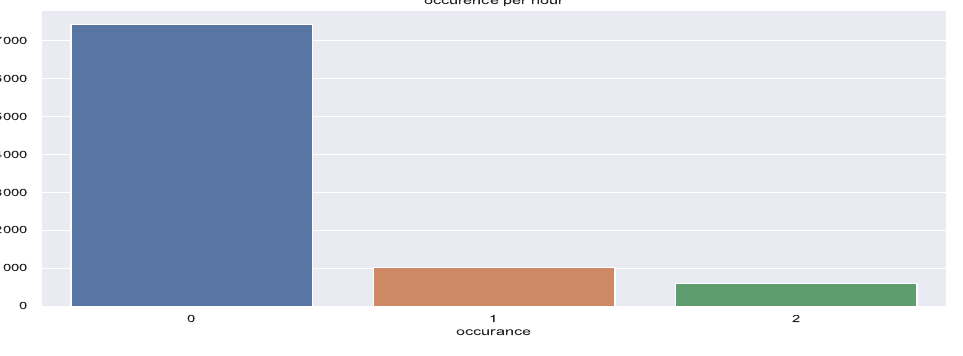
Figure 10. Multi-level data distribution.